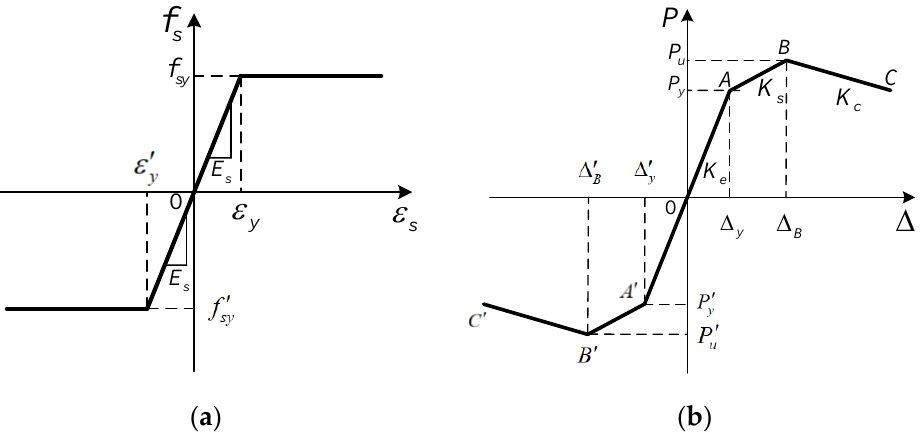
Figure 3. Stress–strain constitutive models: ( a ) reinforcement bar; ( b ) steel plate.